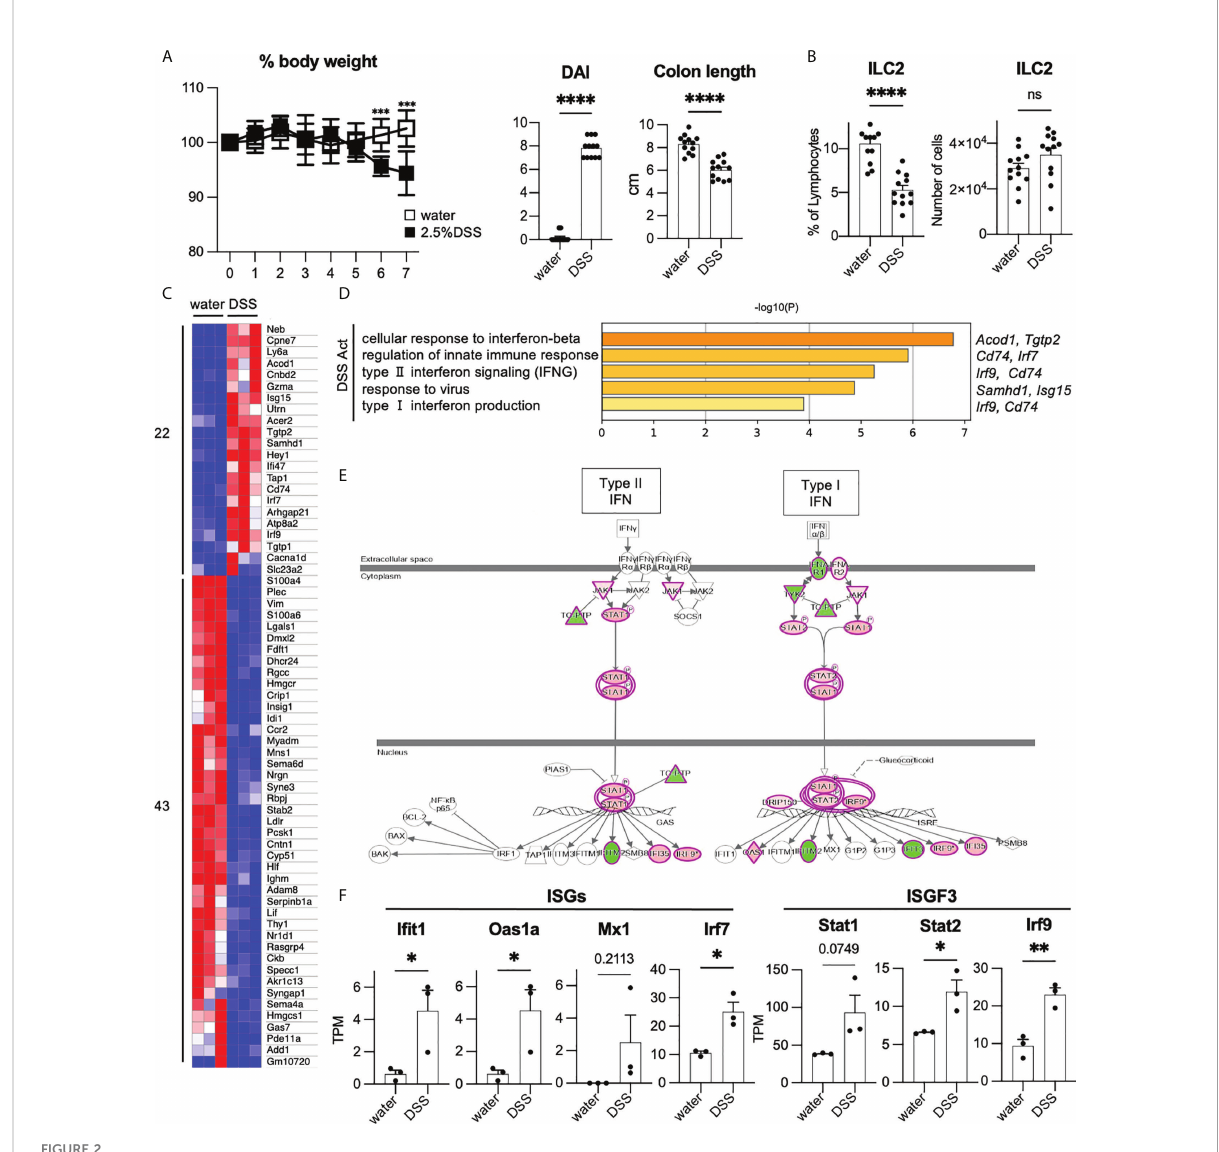
FIGURE 2 Enhancement of T1IFN signaling in ILC2s in DSS-induced colitis (A, B) WT mice were administered DSS for 7 days. Graphs show pooled data from three independent experiments (n=12 for each group). (A) Change in % body weight relative to initial body weight of control mice (drinking water) and DSS-treated mice in two representative experiments (n=8 for each group). Disease activity index (DAI) score on day 7 and colon length of mice of each group (n=12 for each group). (B) % lymphocyte and absolute number of colonic ILC2s in each group (n=12 for each group). (C) Heatmap showing relative gene expression of highly expressed differentially expressed (DE) genes (max TPM>10, log2FC>1, log2FC<- 1) and the number of upregulated (22 genes) and downregulated genes (43 genes) in DSS treated (n=3) compared to that of control mice (n=3). (D) Gene Ontology (GO) analysis of the DSS-activated genes de fi ned in panel C including names of representative genes. (E) Ingenuity pathway analysis (IPA) of interferon signaling pathway of genes differentially expressed in DSS-induced colitis. (F) Absolute gene expression (TPM) of Type I IFN related genes. Data are mean and SEM in (A, B, F) ns, not signi fi cant; * P < 0.05, ** P < 0.01, *** P < 0.001, **** P <